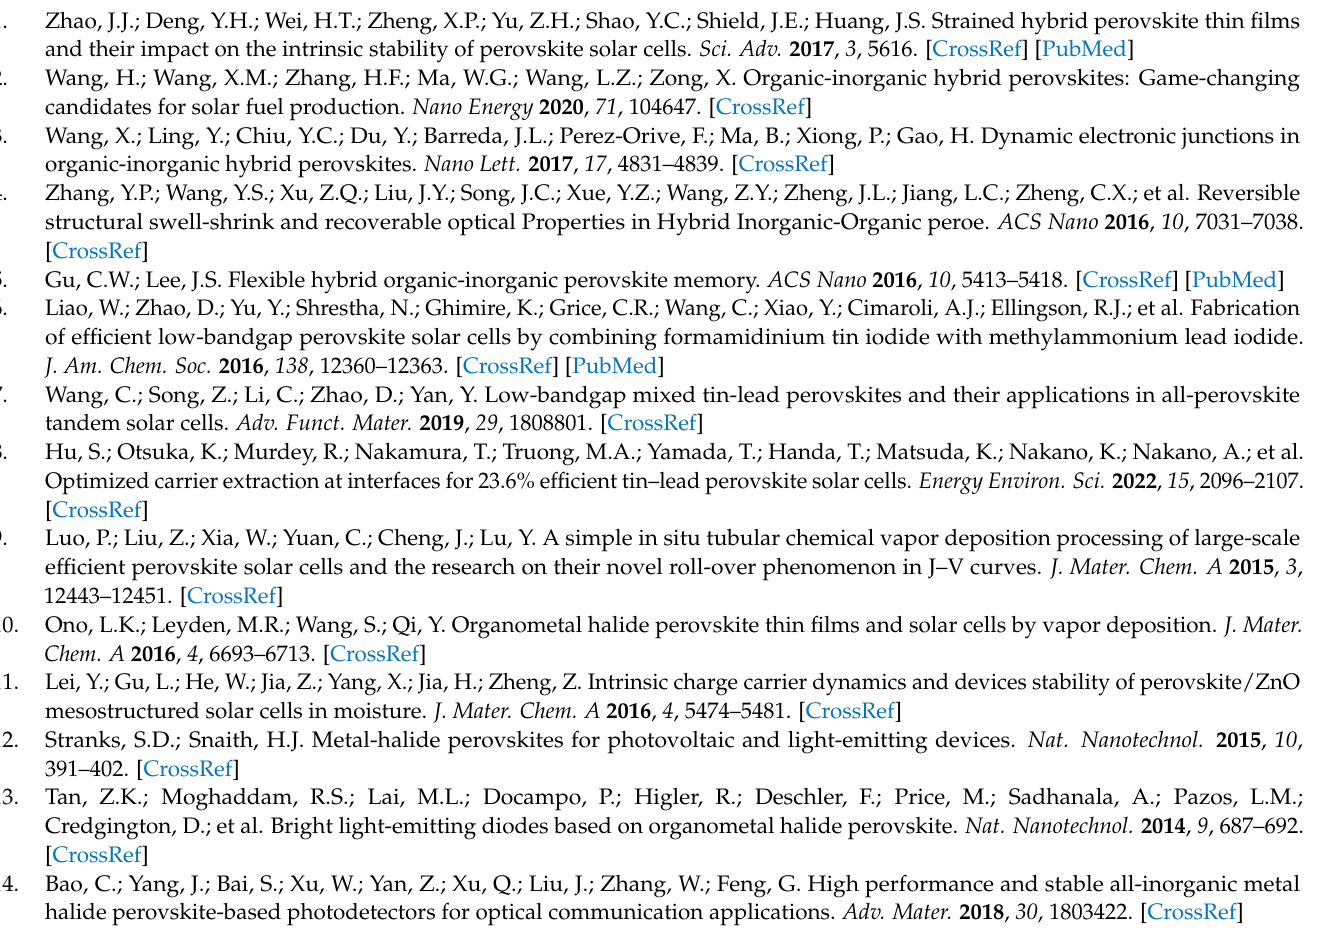
four different perovskite photodetectors. Table S3: A performance comparison between the reported perovskite photodetectors and this work. Table S4: A comparison of a single perovskite detector and four perovskite detectors in parallel without or with inductors; Video S1: Audio transmission demonstration. References [24,42,44–51] are cited in the Supplementary